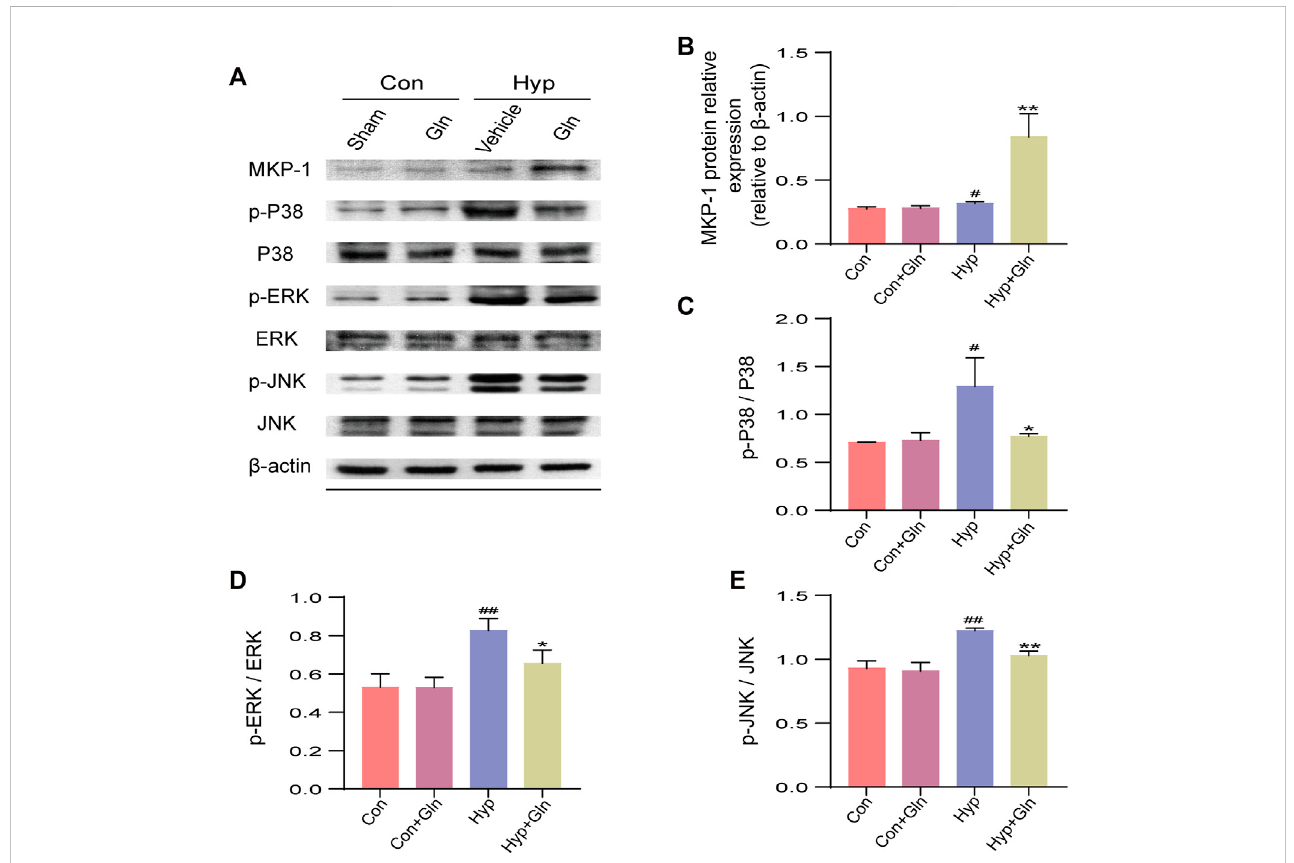
FIGURE 8 Gln amelioration of hyperoxia-induced brain injury may be related to MKP-1/MAPK signaling pathway. (A) Representative images of Western blotting analysisofMKP-1,p-p38,p38,p-ERK,ERK,p-JNK,andJNKofeachgroup. (B) Quanti fi cationofMKP-1.Con(0.28±0.01),Con+Gln(0.28±0.01),Hyp(0.32± 0.01), Hyp + Gln (0.84 ± 0.11). (C) Ratio of p-p38 to p38. Con (0.71 ± 0.00), Con + Gln (0.73 ± 0.05), Hyp (1.29 ± 0.17), Hyp + Gln (0.77 ± 0.02). (D) Ratio of p-ERKtoERK.Con(0.53±0.04),Con+Gln(0.53±0.03),Hyp(0.83±0.04),Hyp+Gln(0.66±0.04). (E) Ratioofp-JNKtoJNK.Con(0.93±0.03),Con+ Gln(0.91±0.04),Hyp(1.23±0.01), Hyp+Gln(1.03±0.02).( n =3). # p < 0.05, ## p < 0.01 vs.theCon,* p < 0.05,** p < 0.01vs.theHyp. p < 0.05wasconsidered statistically signi fi